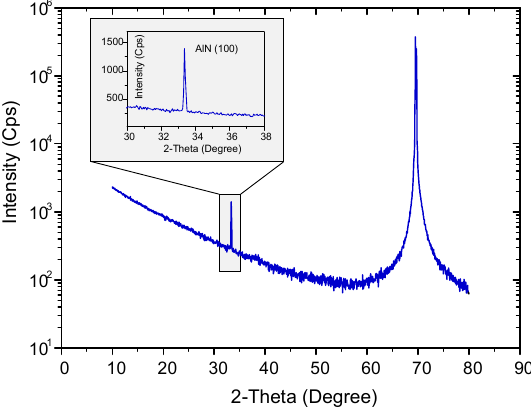
Figure 5. XRD spectrum of the AlN thin film grown by PLD.